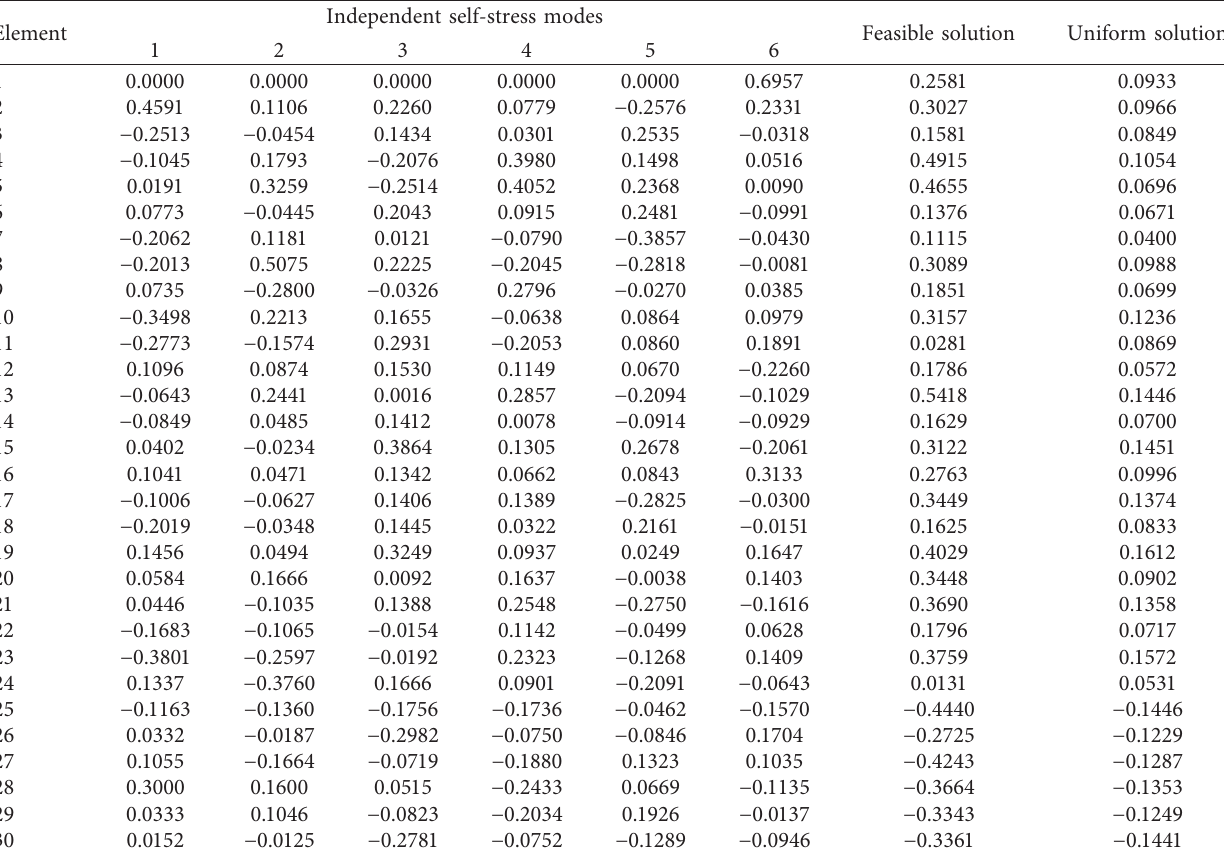
Figure 4: Geometry configuration of the spatial 6 struts tensegrity structure. (a) Overhead view and (b) perspective view. Table 2: The feasible and uniform solutions of the initial self-stress